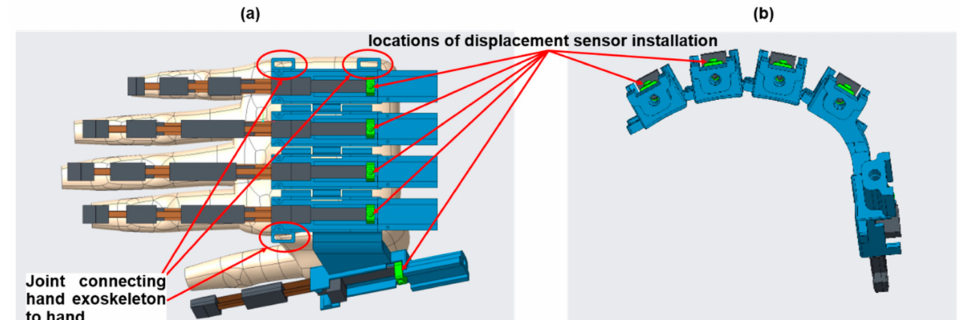
Figure 5. ( a ) Top view of the displacement sensor installation on the hand exoskeleton, ( b ) front view of the displacement sensor installation.